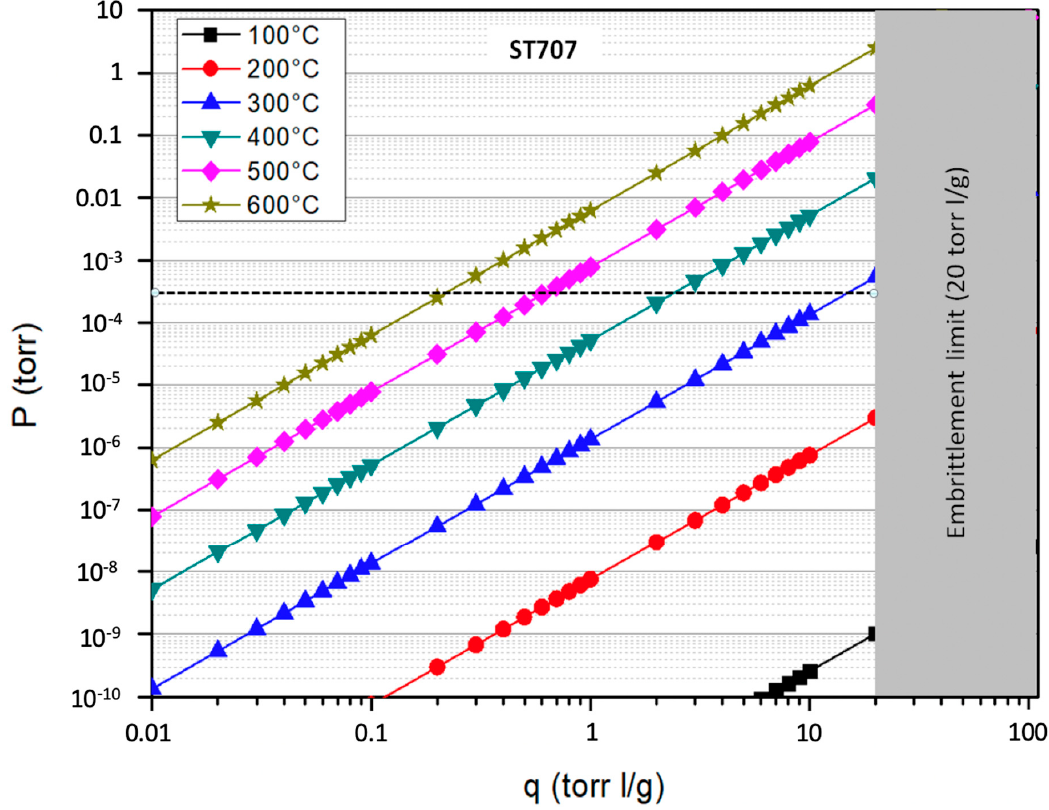
Figure 4. Sieverts’ plot of the ST707 alloy.